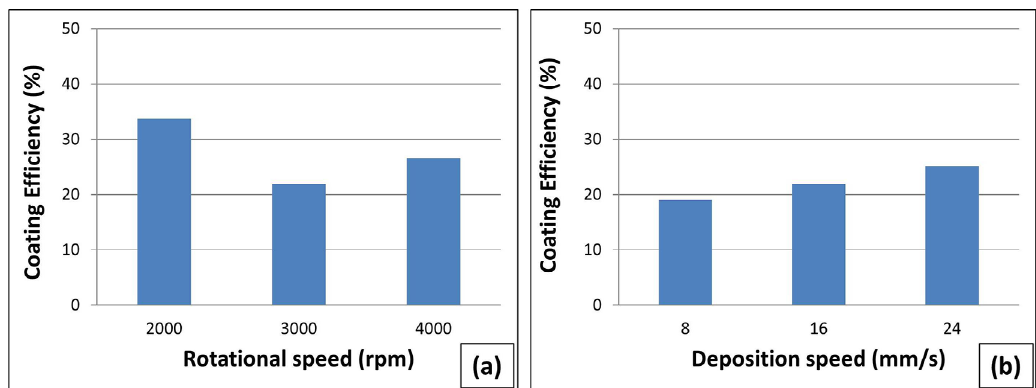
Figure 3. Coating efficiency as a function of the (a) rotational and (a) deposition speeds.